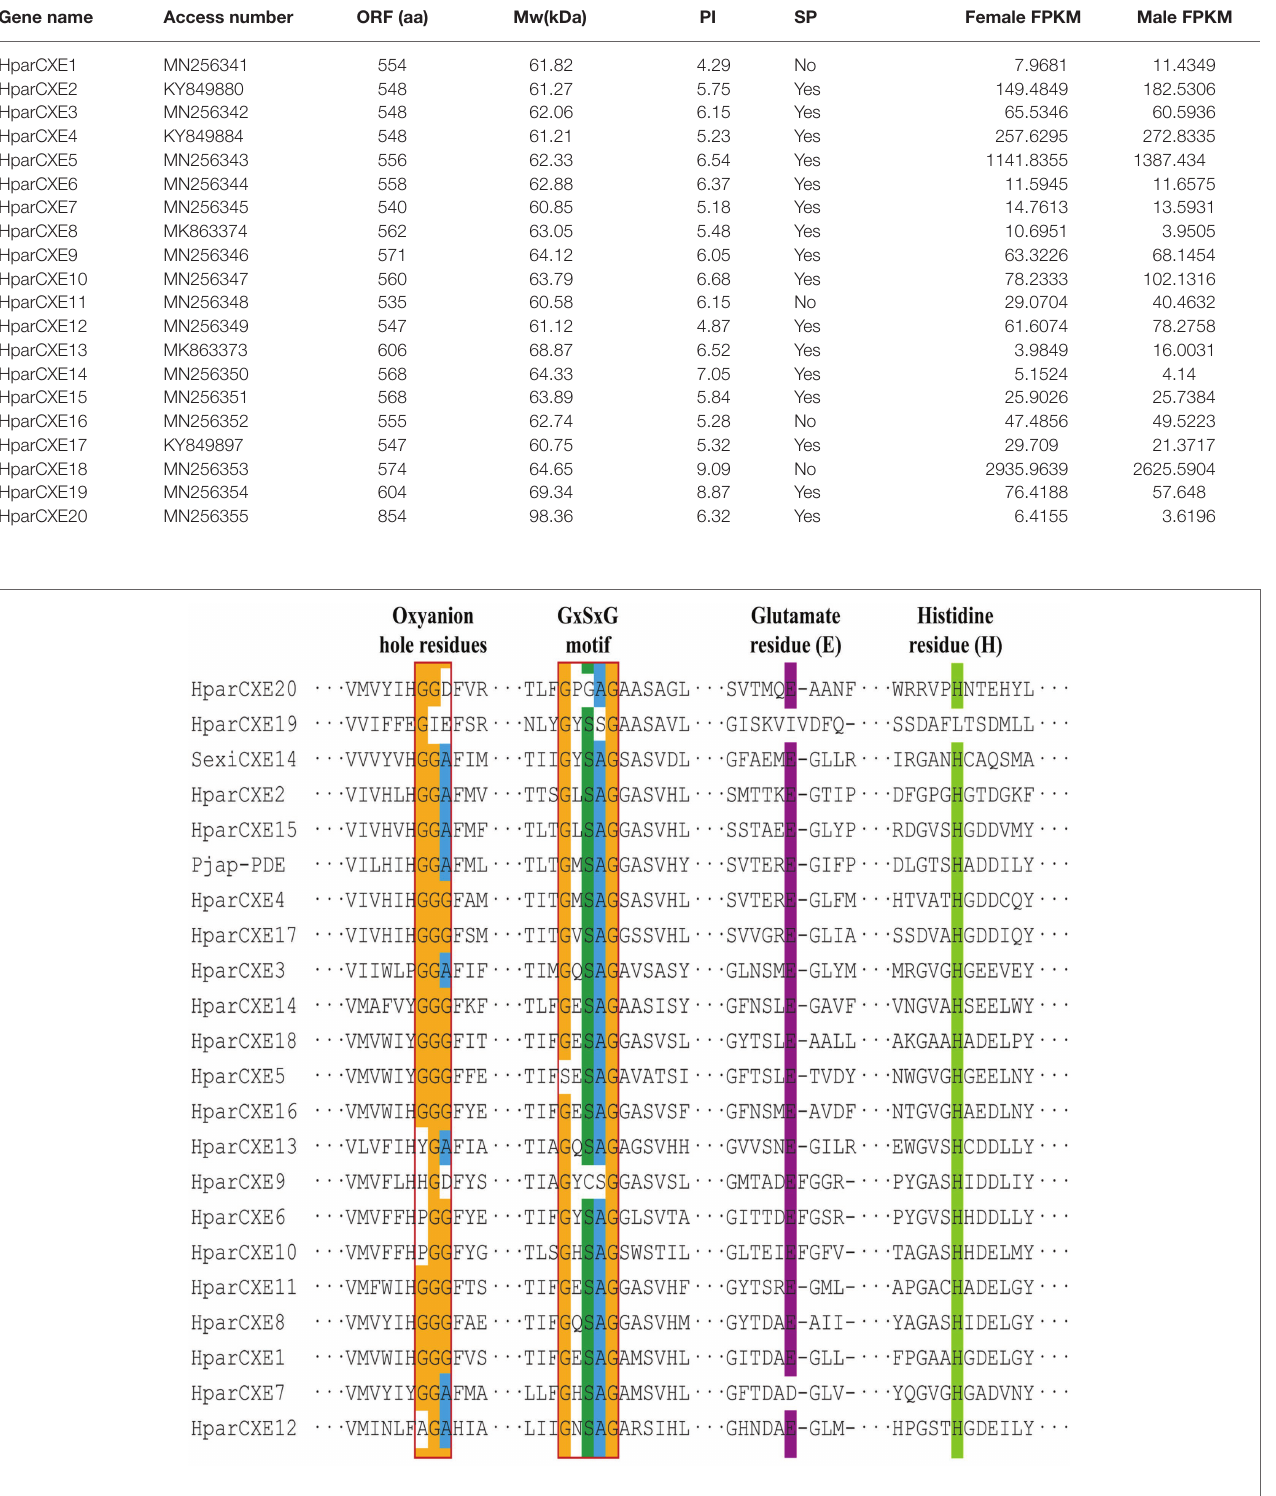
TABLE 2 | Molecular characteristics and access numbers of candidate carboxylesterases.